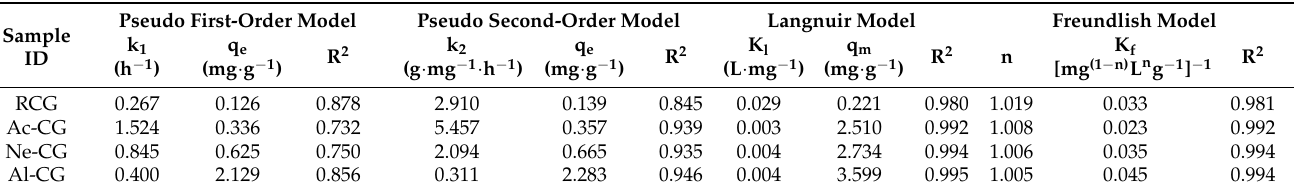
Figure 3. Adsorption kinetics curves ( a ) and adsorption isotherms curves ( b ) of coal gangue samples toward phosphate. Error bars represent standard error of the mean ( n = 3). Table 2. Parameters of phosphate adsorption kinetic and isotherm of coal gangue samples.